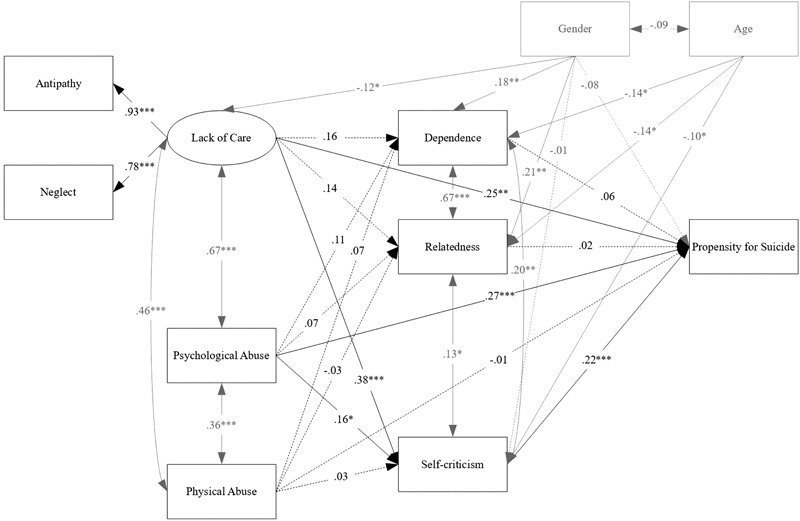
Estimated structural equation model. Maximum likelihood standardized coefficients are shown. Solid lines represent significant pathways, dashed lines are non-significant. Covariances, control variables and their related paths are presented in light gray. ∗p < 0.05, ∗∗p < 0.01, ∗∗∗p < 0.001.